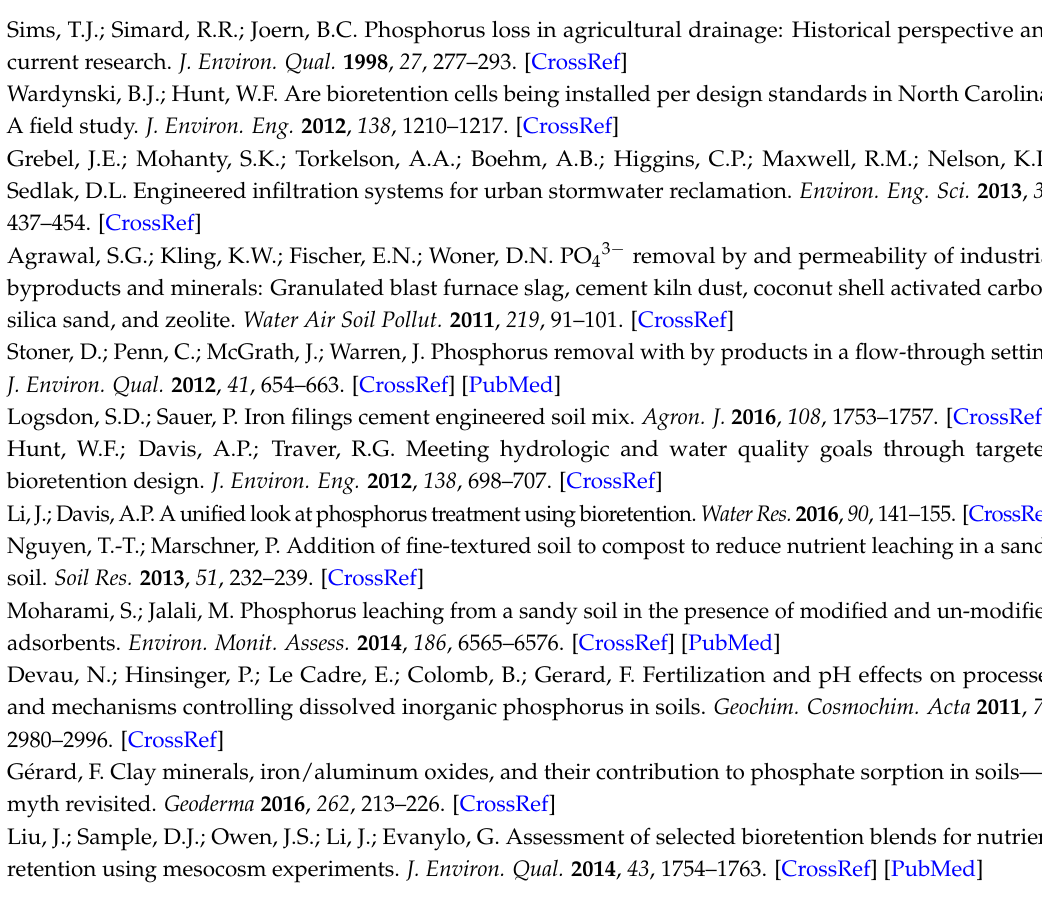
Table S1. Saturated and unsaturated infiltration rates and time to initial drainage for the soil mixes (across compost treatments) for pre-plant and post-harvest; Table S2. Saturated and unsaturated infiltration rates and time to initial drainage for the compost treatments (across soils) for pre-plant and post-harvest; Table S3. Mass of grass and clover, surface bulk density, and root depth for the soil mixes averaged across those with and without compost blankets; Table S4. Nitrate in saturated and unsaturated effluent of compost blanket treatment (across soils), before planting and after harvest. Also calculated total phosphorus load in preplant and post-harvest effluent, based on outflow volumes for saturated and unsaturated effluent; Table S5. Total phosphorus in saturated and unsaturated effluent of compost blanket treatment (across soils), before planting and after harvest. Also calculated total phosphorus load in preplant and post-harvest effluent, based on outflow volumes for saturated and unsaturated